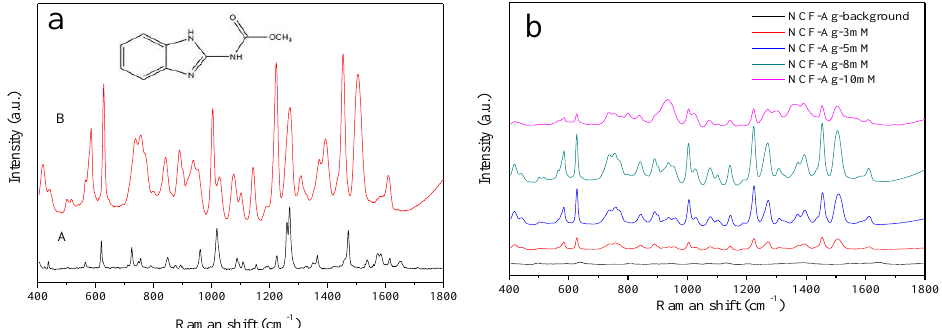
Figure 3. ( a ) Spectra of carbendazim (CBZ): (A) Raman spectrum and (B) SERS spectrum of 10 −4 M CBZ detected with NCF-Ag NPs prepared with 8 mM AgNO 3 . ( b ) SERS spectrum of the NCF-Ag NPs with 8 mM AgNO 3 and SERS spectra of 10 −4 M CBZ detected with NCF-Ag NPs prepared with 3, 5, 8, and 10 mM AgNO 3 .